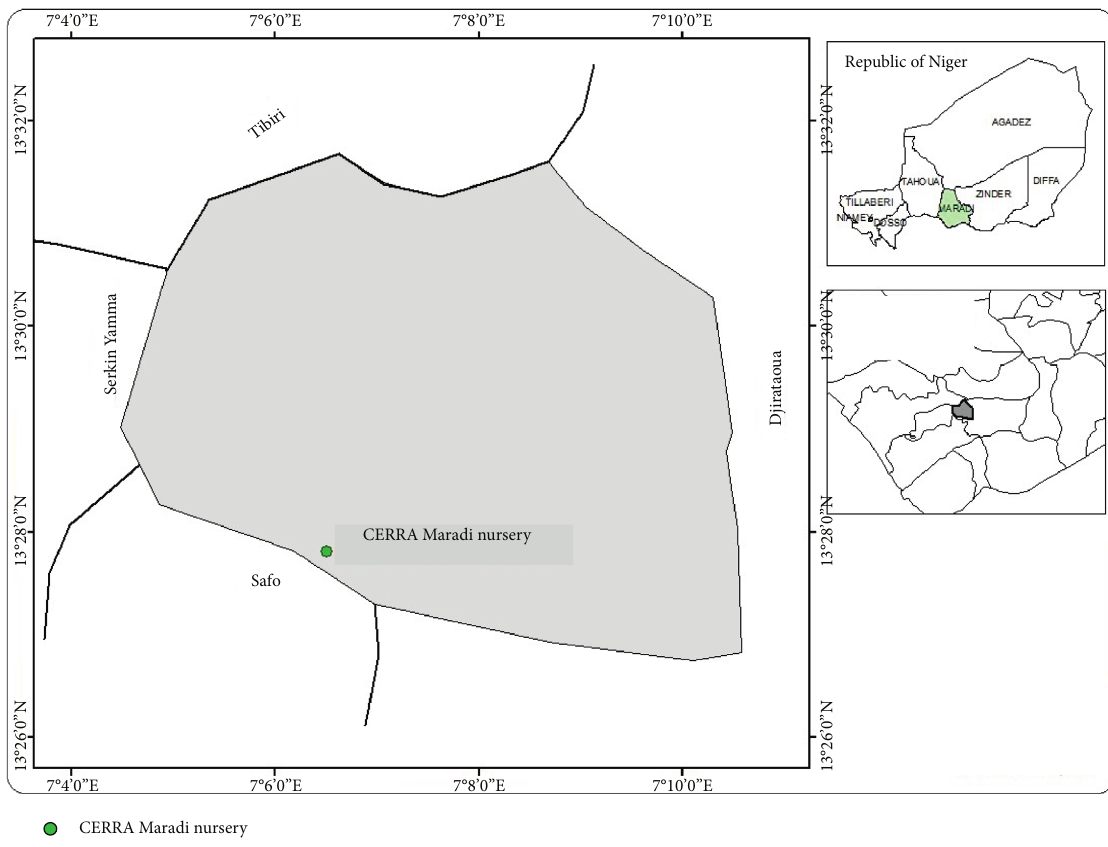
Figure 1: Location of the study zone.